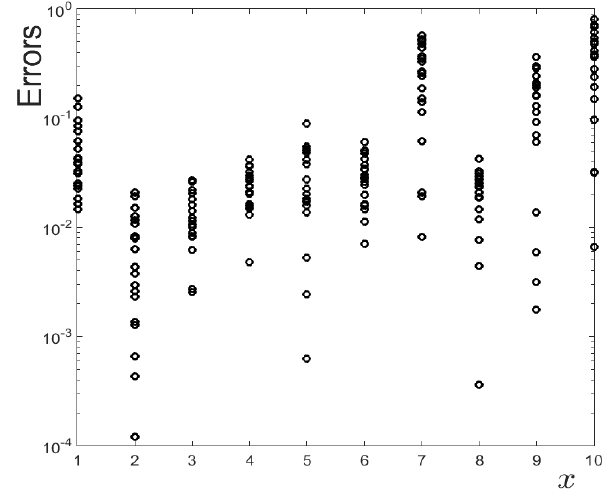
) are computed along and T 2 4 t 4 t